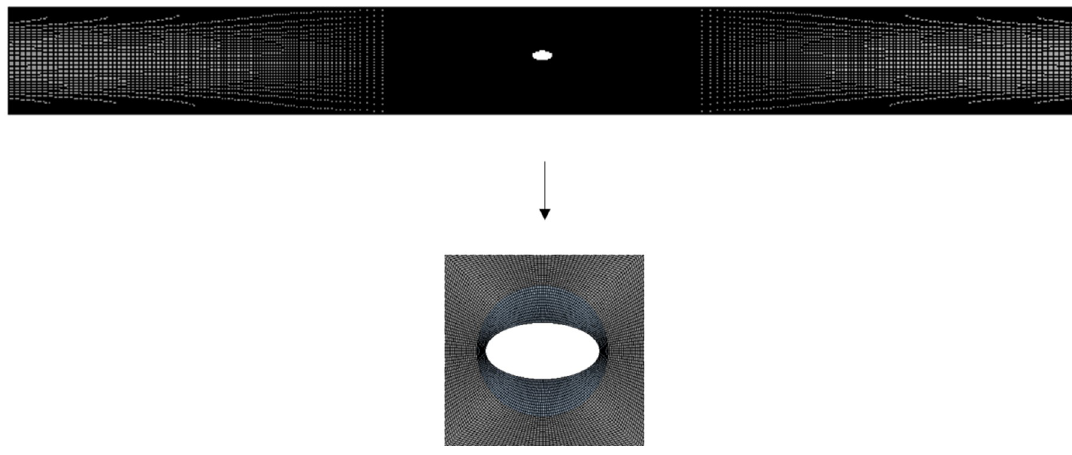
Fig 2. Schematic diagram of the